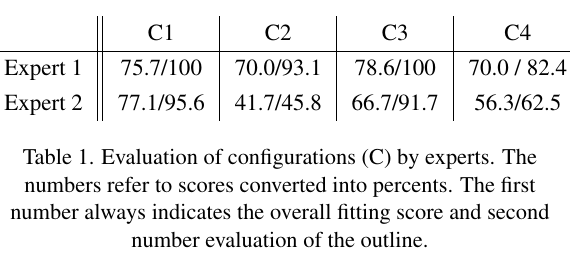
Figure 1. Illustration of geo-typical building modeling. Image (a): A building in the multi-spectral image outlined by white polygon stemming from the GIS data, (b) shows a library building having the highest similarity. Its blue outline polygon is projected into (a) using homography h , yielding the dashed blue polygon. Image (c) shows the superposition of bitplanes yielding the highest score. Here, yellow means the intersection of two rasterized images while red and green denote parts of the library building not present in the source building and, respectively, vice-versa. Image (d) shows the superposition of bitplanes induced by a different homography and yielding a considerably lower score. Image (e) shows the 3D model of the library building to be reproduced. Images (f) and (g) are cutouts from the high-resolution images around buildings in (a) and (b), respectively.